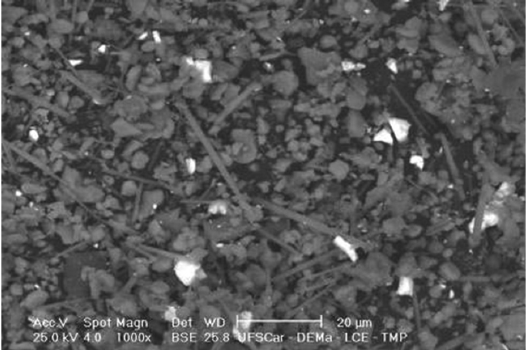
Figure 3. BSE (×1,000) of RP powder.